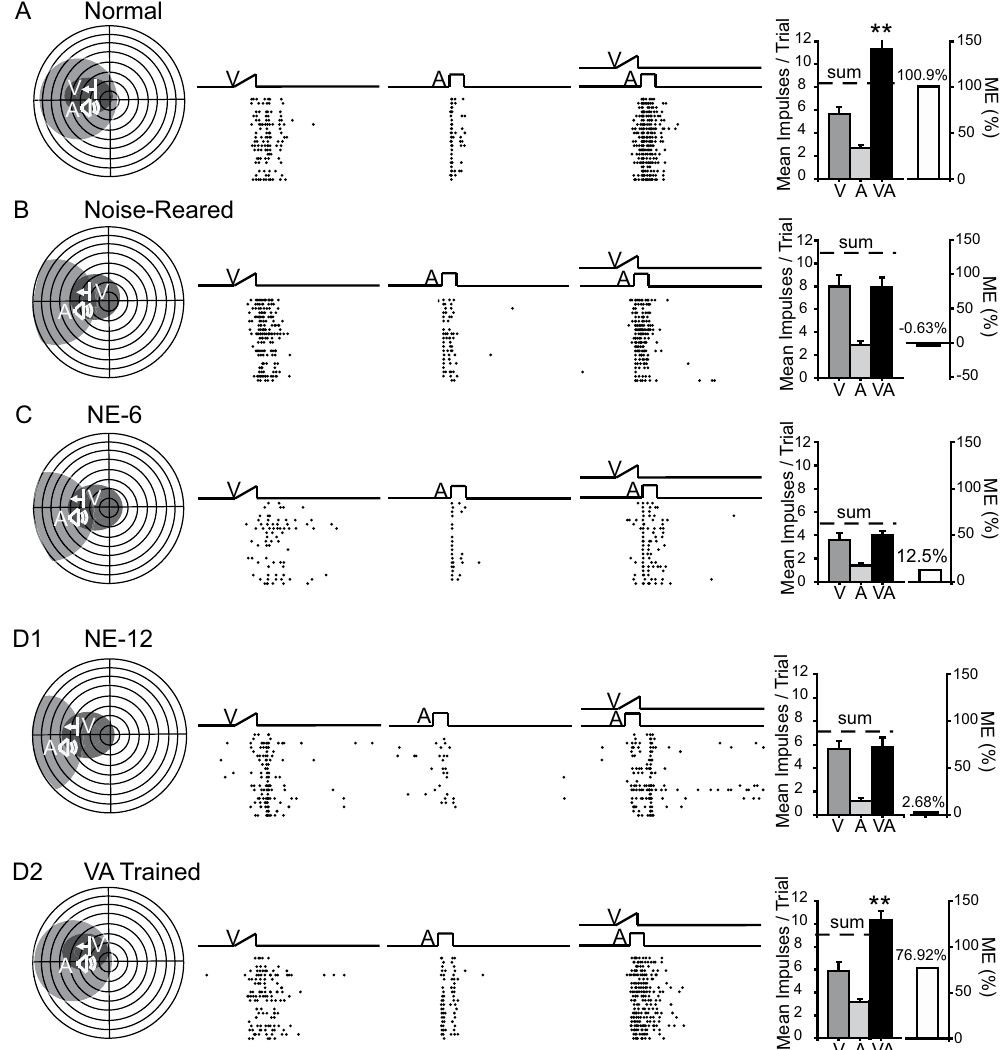
Figure 3. Exemplar neurons illustrating the results of cross-modal testing in various conditions. ( A ) The normal profile of multisensory enhancement in superior colliculus (SC) neurons. Left: a neuron’s visual (dark gray) and auditory (light gray) receptive fields (RFs), and the positions of the visual and auditory stimuli, are shown on the schematic. Conventions are the same as in Fig. 2. Middle: rasters (trials ordered bottom-to-top), show responses to visual (V), auditory ( A ) and spatiotemporally concordant visual-auditory (VA) stimuli. Electronic traces of the stimuli are shown above the rasters. Right: A summary graph of the mean response magnitudes and the multisensory enhancement index (ME) show that the multisensory response significantly exceeded the strongest unisensory comparator response (V) in this normal exemplar. ( B ) With omnidirectional noise-rearing, however, RF register was less precise, and the VA response was no greater than the V response in this baseline condition. ( C ) After 6 months of subsequent experience in a normal housing environment (NE-6), the typical multisensory SC neuron showed little change from baseline. RF overlap was still less precise than normal and no capacity for multisensory enhancement was evident. Its response to the cross-modal stimulus was no greater than to one of the component stimuli. ( D1 ) This profile was little changed after an additional 6 months of housing in the normal environment (NE-12). ( D2 ) In contrast, after weekly visual-auditory cross- modal exposure sessions conducted during the same period, the typical neuron exhibited good RF register as well as multisensory enhancement capabilities (VA Trained). Sum = the addition of the two unisensory responses. Error bars indicate SEM. ** P ≤